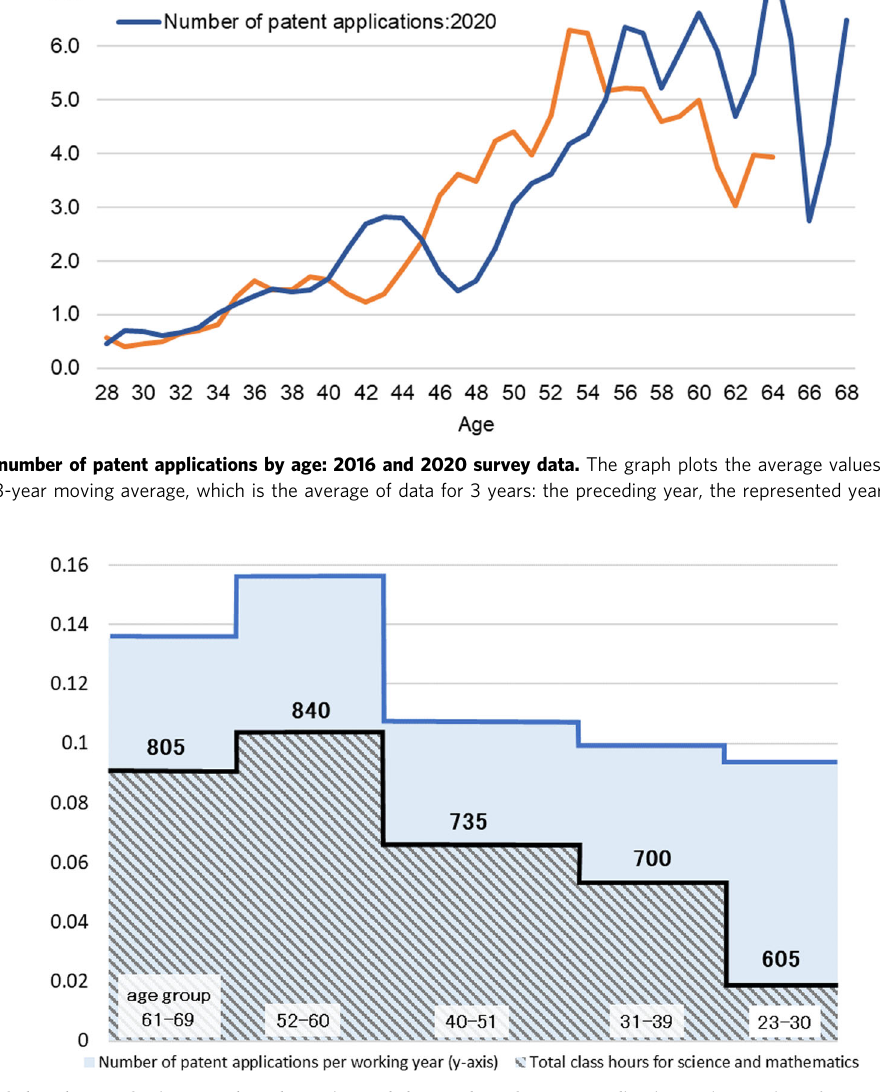
Fig. 5 Total number of class hours of science and mathematics and the number of patent applications. The number of patent applications per working year is the average number per year of employment, averaged for each age group. The total class hours for science and mathematics is the total number of hours of science and mathematics for the 3 years of junior high school. The trend in class hours (shaded) is overlaid over the trend in the number of patent applications (light blue). The height of each graph is not the stacked value. The horizontal axis shows the respondents ’ age. To clarify the relationship between the number of class hours and the number of patent applications, the respondents are grouped by the edition of the curriculum guidelines under which they studied in their fi rst year of junior high